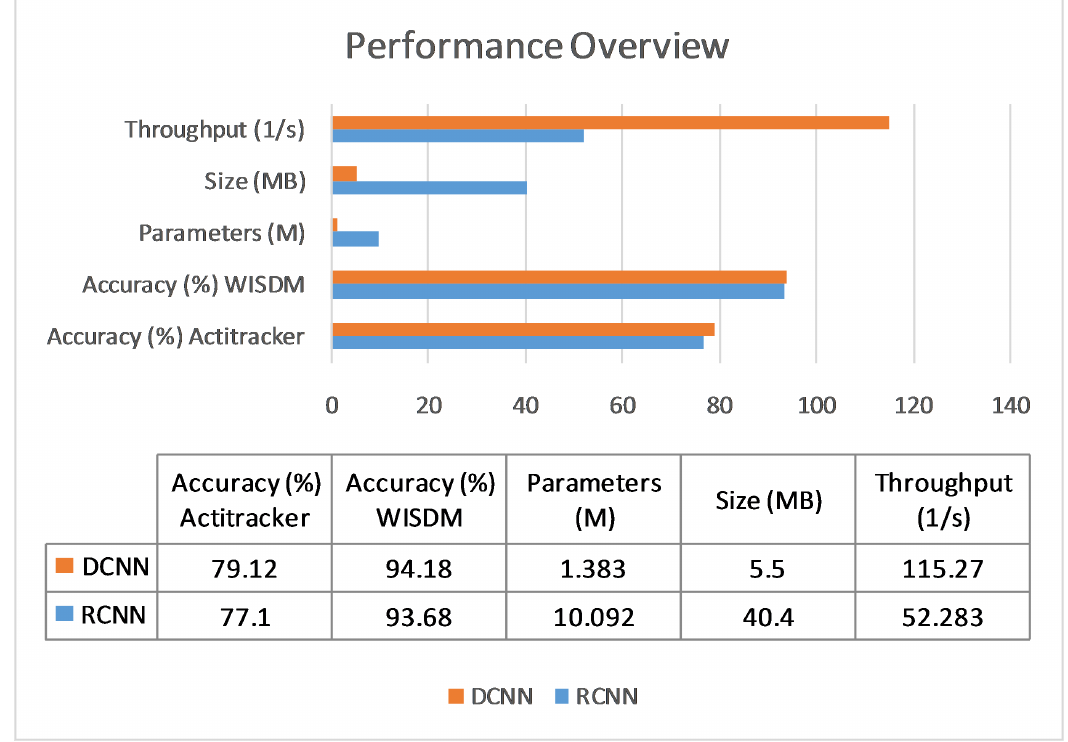
Figure 9. Overview of the performance of the proposed model. It is noted that in the accuracy and throughput categories, the higher the better, while the inverse holds for the size and the number of